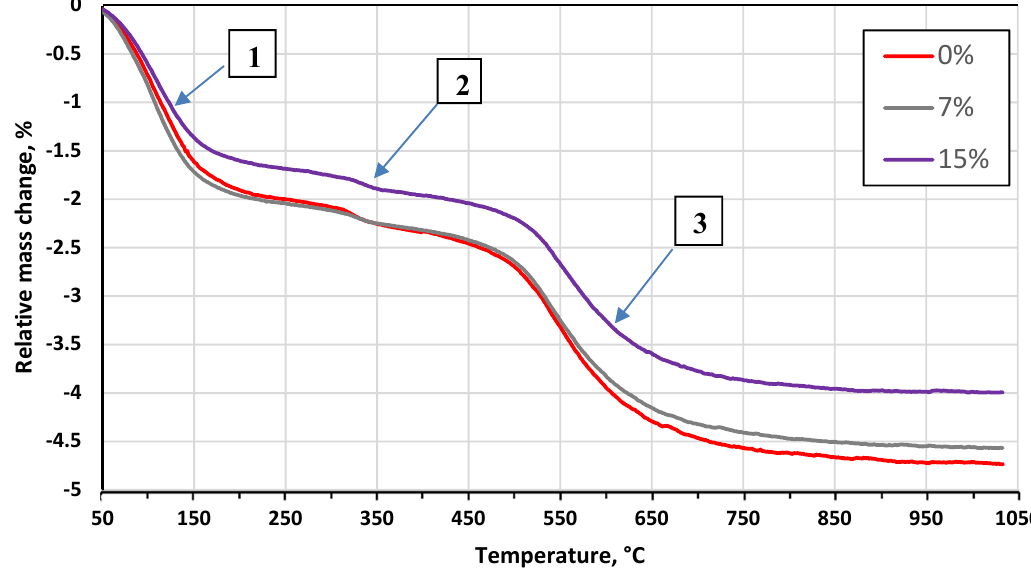
Figure 3. Thermogravimetric (TG) analysis results of the tested clay-glass ceramic materials in temperature range from 20 up to 1050 °C. Detected events (1, 2, and 3) are indicated. The content of glass in wt% is in the legend.